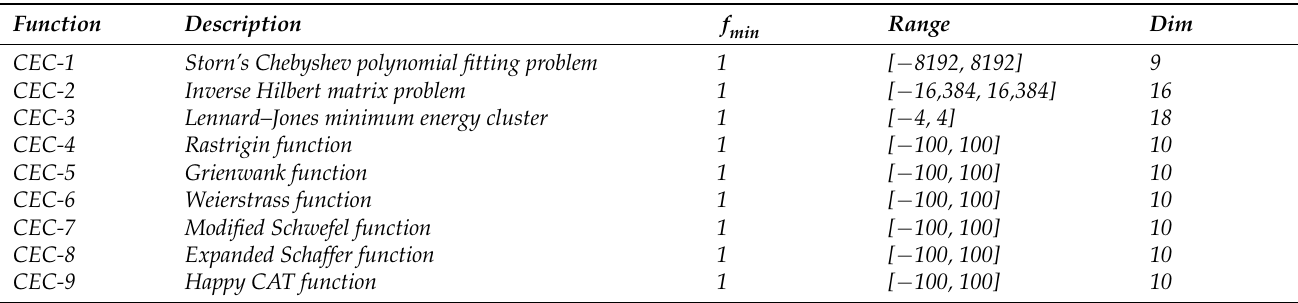
Table A4. Utilized CEC 2019 Test